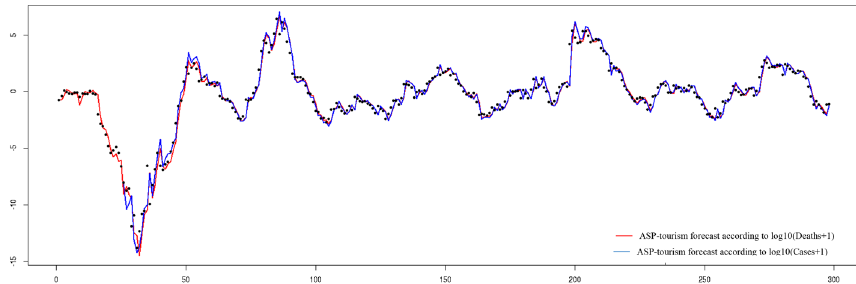
Fig. 5 Fit of the tourism industry’s abnormal stock price according to the confidence band of the applied model. Source : Authors’ own